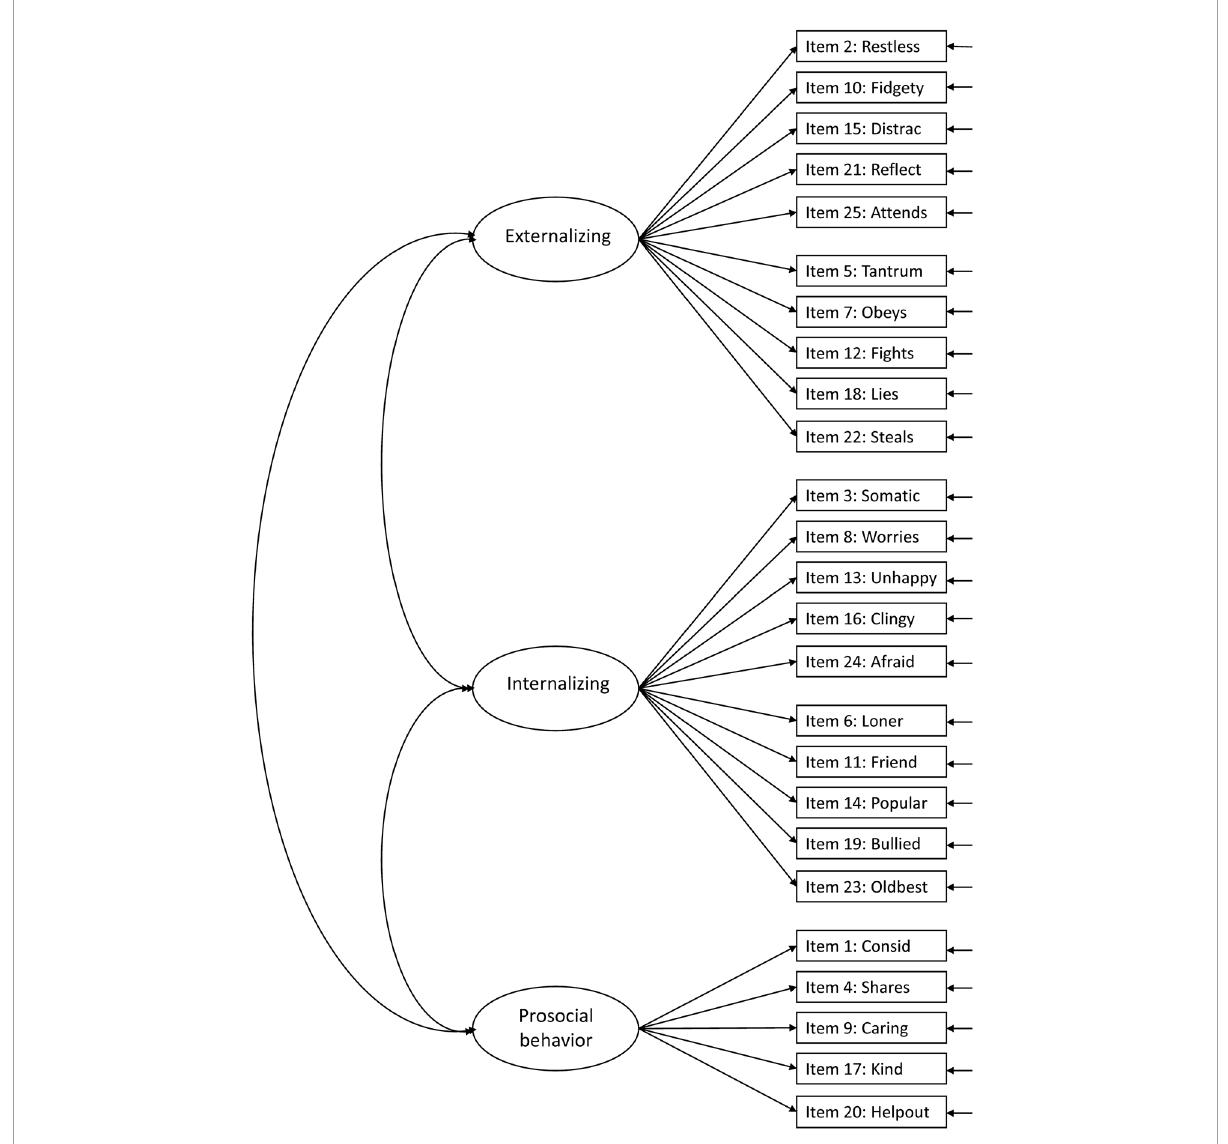
FIGURE3 Three-factor model with internalizing, externalizing, and prosocial behavior as factors (Model 3).